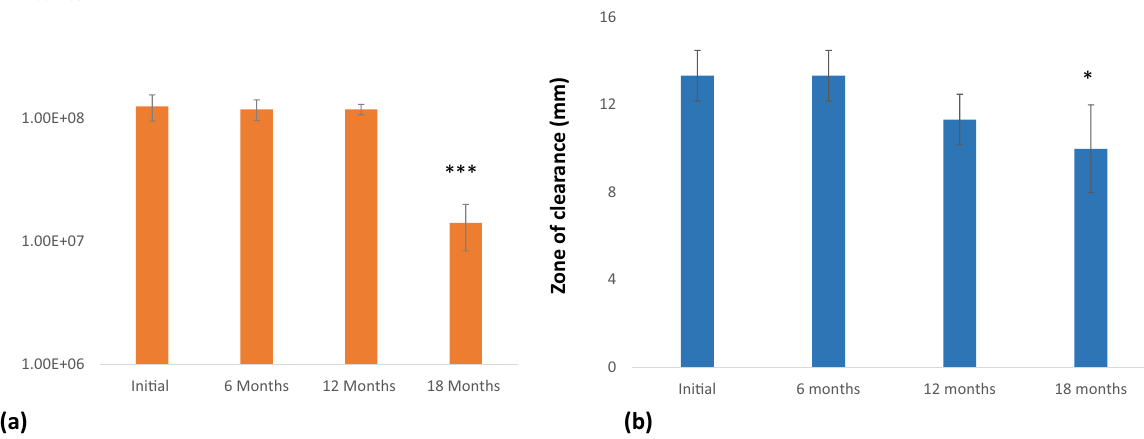
Figure 15. ( a ) Stability of lyophilized DRL-P1 at different time interval. Lyophilized phages were reconstituted in TM buffer and titers determined through standard double layer plaque assay. Bars represents mean ± SD from the three vials tested at each time point. *** P < 0.001 indicate significant difference between the initial titre and the stored lyophilized phage samples, after 18 months. ( b ) Stability of DRL-P1 in alginate capsules at different time interval. Zone of clearance by phage loaded alginate beads over the lawn of P. aeruginosa was measured. Bars represents mean ± SD from the three samples tested at each time point. * P < 0.05 indicate significant difference between the initial titre and the phage loaded in alginate beads after 18 months. Plots were generated using the chart function incorporated in Excel program (MS Office version 18.2106.12410.0) and statistical analysis were performed using the GraphPad PRISM computer program (Trial version 7.05; https:// www. graph pad. com/ scien tific- softw are/